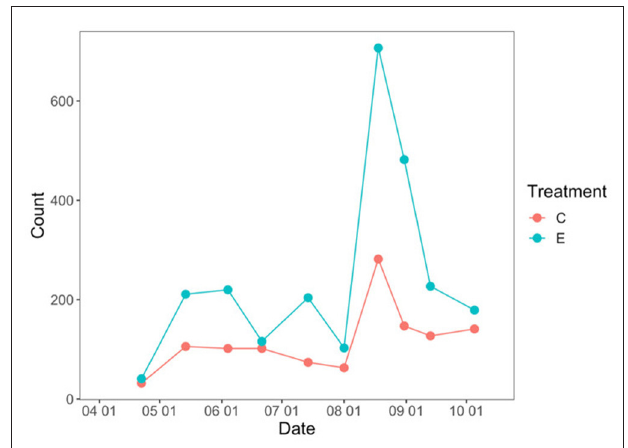
FIGURE 1 | Total flowering plant count between deer exclusion (E) and control plots (C) over the course of the growing season.